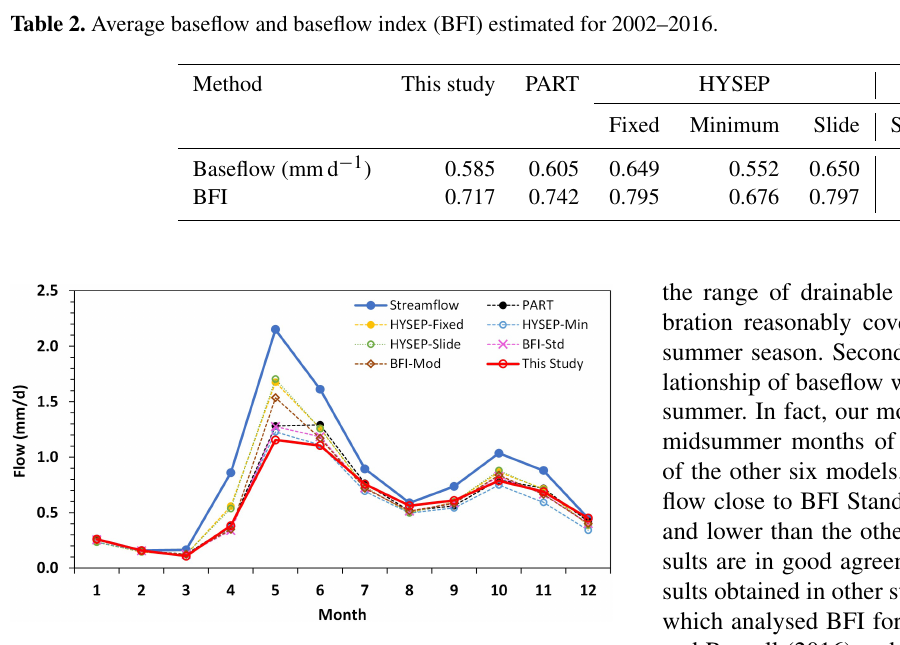
Figure 9. Observed total streamflow and estimated baseflow by different methods for the Albany River. Data shown are monthly means in the 15 years of 2002–2016.